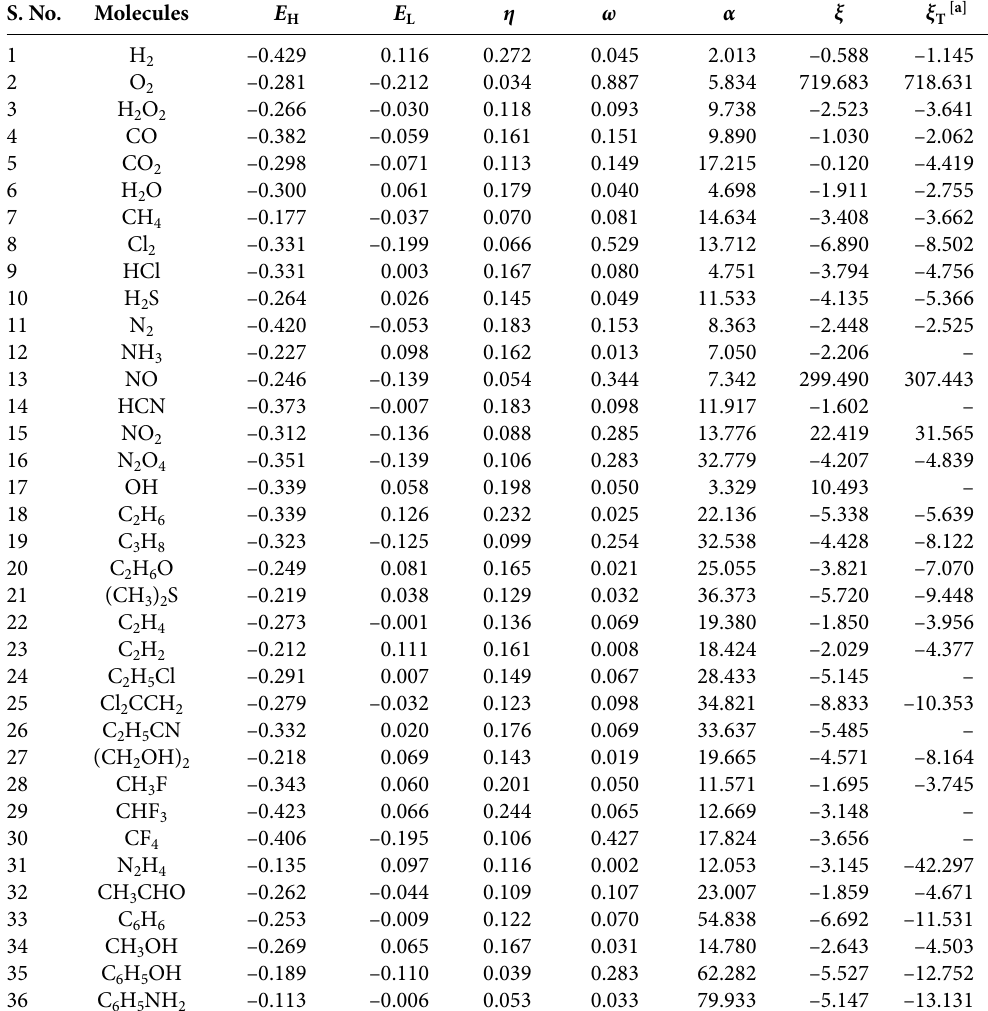
Table 1. Computed frontier orbital energies ( E H and E L ), hardness ( η ), electrophilicity index ( ω ), polarizability ( α ) and magnetizability ( ξ ) values of the reactant and product molecules of the selected reactions using B3LYP/LanL2DZ meth- od and their tabulated magnetizabilities ( ξ T ) (in au) S.